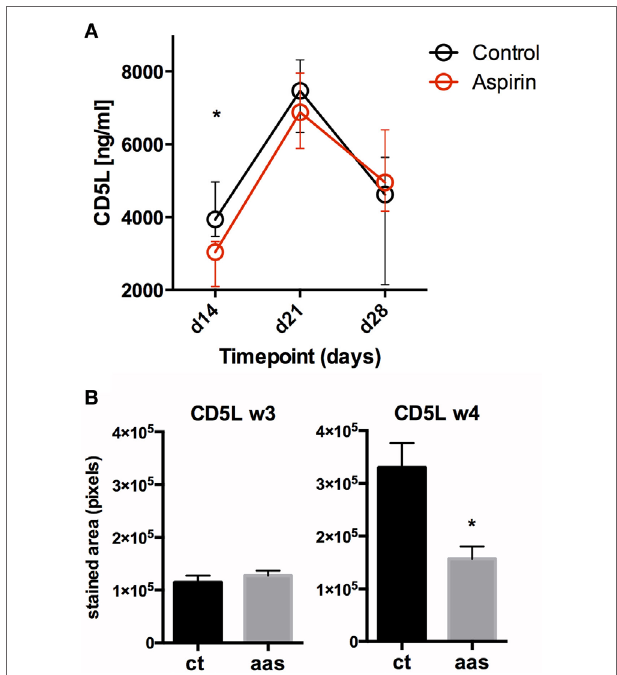
FigUre 5 | Impact of AAS on CD5L at a systemic and local level. Panel (a) shows serum levels (in pg/mL) for CD5L over time. Panel (B) shows CD5L in lung tissue on days 21 (week 3) and 28 (week 4) after challenge. Abbreviations: Ct, control; AAS, aspirin; d, day; w,